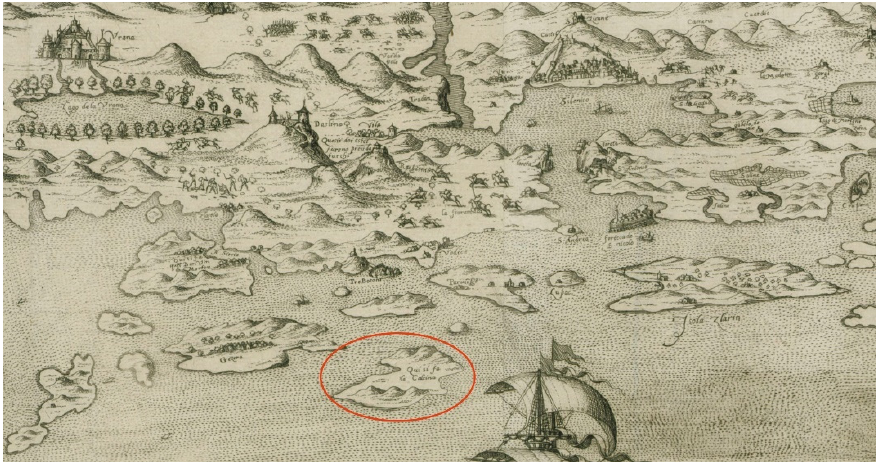
Figure 6. Excerpt from Koluni ć ’s map of the Šibenik region, Venice, 1570. Red ellipse denotes Žirje Island entitled Qui si fa la Calcina (Lime is produced here).